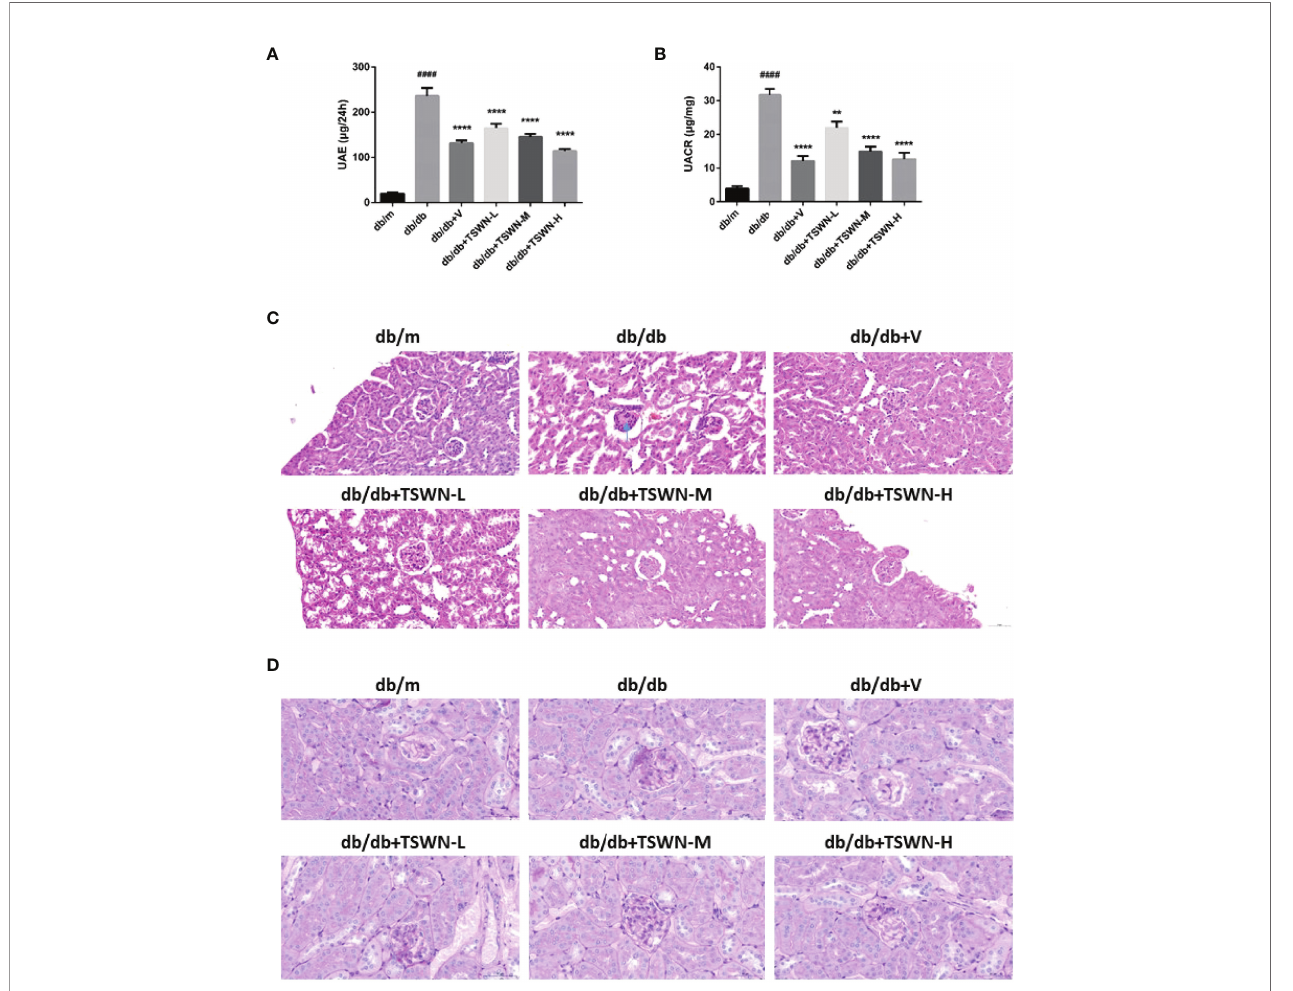
FIGURE 3 | Renal phenotype of mice. (A) Urinary albumin excretion (UAE). (B) Urinary albumin-to-creatinine ratio (UACR). (C) Representative photographs of mouse kidneys by Hematoxylin & Eosin (H&E) staining. (D) Representative photographs of mouse kidneys by Periodic Acid Schiff (PAS) staining. n = 6 mice/group. #### P < 0.0001 vs db/m group; **P < 0.01 vs db/db group. Db/m, db/m mice; db/db, db/db mice; db/db+V, db/db mice with valsartan treatment; db/db+TSWN-L, db/db mice with low dose TSWN treatment; db/db+TSWN-M, db/db mice with middle dose TSWN treatment; db/db+TSWN-H, db/db mice with high dose TSWN treatment. Data are means ±